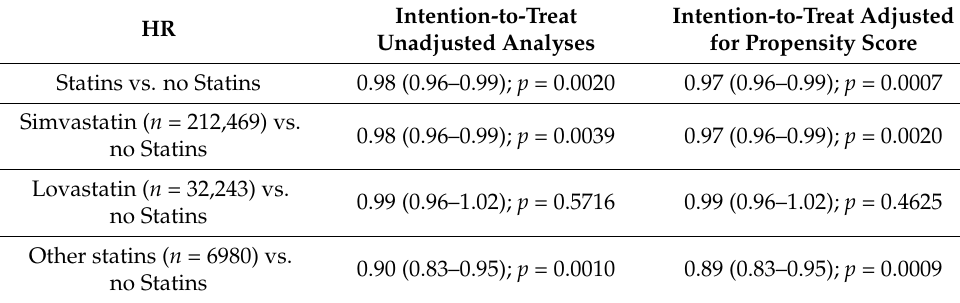
Table 3. Number of events, length of follow-up, time to event and incidence per 1000 patient-years in the non-statin vs. statin initiator groups. Incidence, per Time to Event Follow Up, Number of 1000 among Patients Years, Mean Category Events (%) Patient-Years Developing ADRD (STD) No Statins 32,699 12.7 (5.6) 8.5 (5.2) 10.3 ( n = 251,692) (13.0%) Statins 32,890 13.0 (5.6) 8.8 (5.1) 10.0 ( n = 251,692) (13.0%) Table 4. Hazard ratio estimates for statin initiation. Intention-to-Treat Intention-to-Treat Adjusted HR Unadjusted Analyses for Propensity Score Statins vs. no Statins 0.98 (0.96–0.99); p = 0.0020 0.97 (0.96–0.99); p = 0.0007 Simvastatin ( n = 212,469) vs. 0.98 (0.96–0.99); p = 0.0039 0.97 (0.96–0.99); p = 0.0020 no Statins Lovastatin ( n = 32,243) vs. 0.99 (0.96–1.02); p = 0.5716 0.99 (0.96–1.02); p = 0.4625 no Statins no